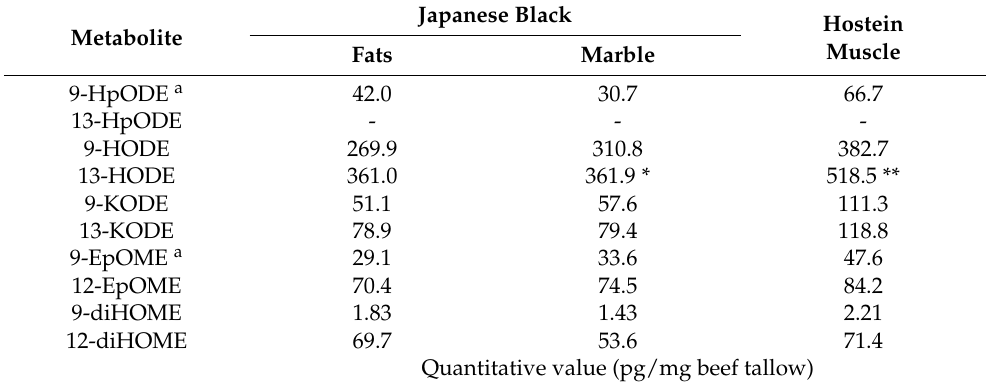
Table 2. Low-temperature vacuum extraction of beef tallow using a water ejector vacuum